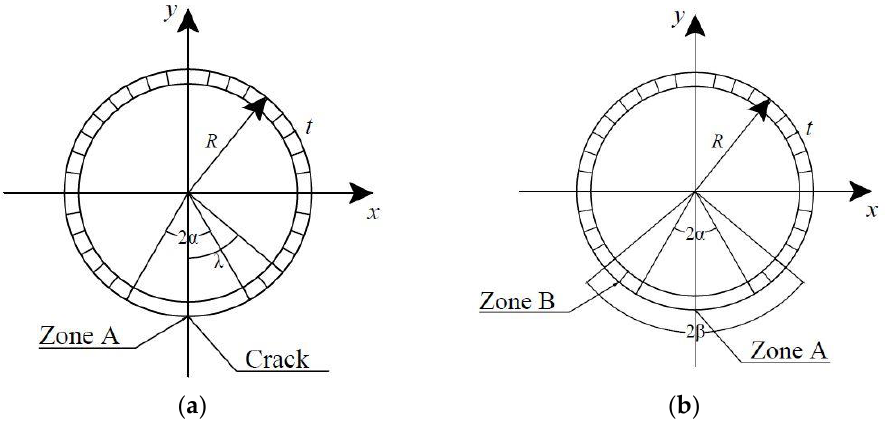
Figure 10. Crack sections for linear elastic and elastic-plastic materials. ( a ) Section with circumfer- ential crack for linear elastic material; ( b ) Section with circumferential crack for elastoplastic mate-